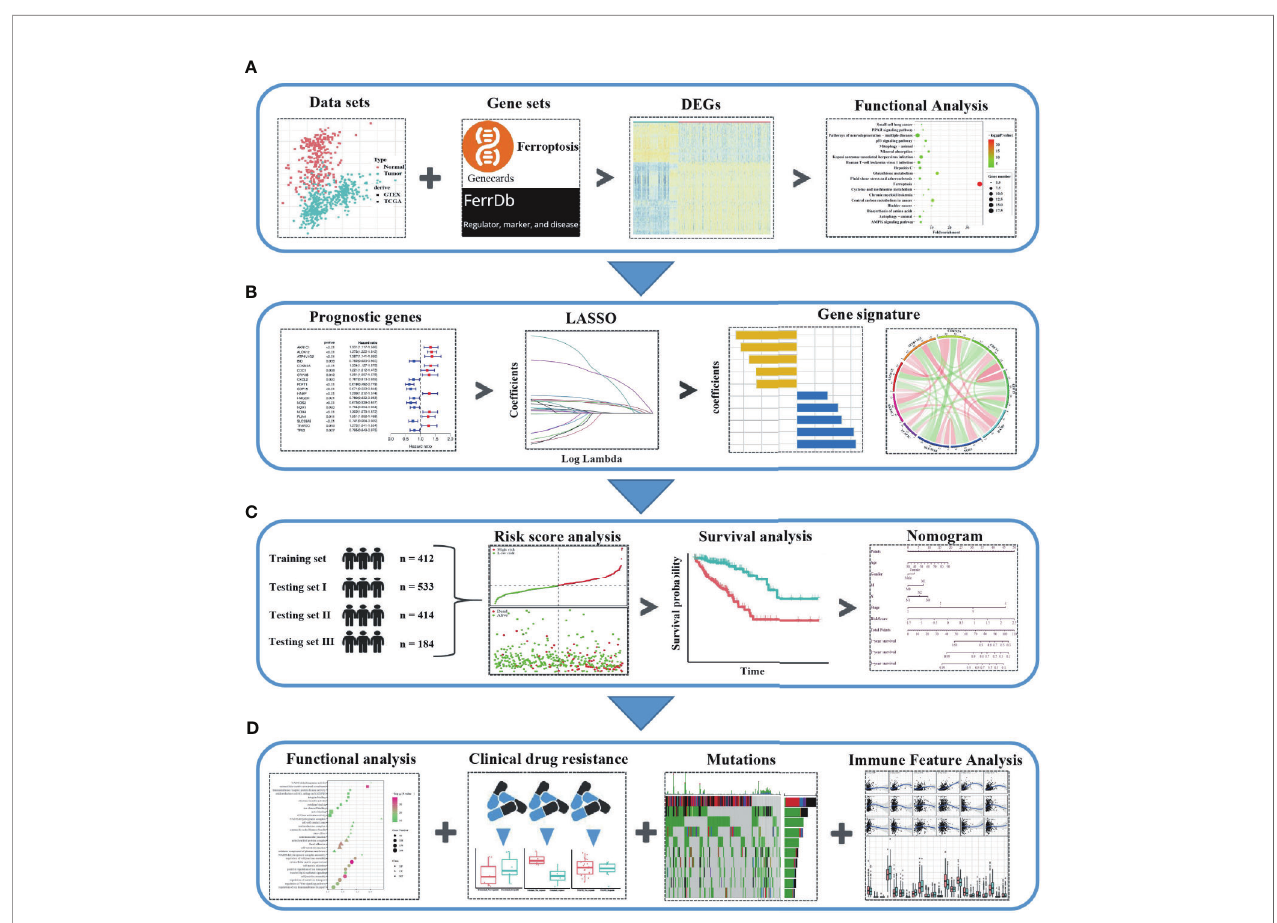
FIGURE 1 | Schematic diagram of the study design. (A) The ferroptosis-related differentially expressed genes (DEGs) were identi fi ed between the tumor and normal colon tissues in the GTEx and TCGA datasets. (B) Based on these DEGs, the survival associated ferroptosis DEGs were identi fi ed in the TCGA dataset and the LASSO COX analysis was conducted to construct the ferroptosis-related gene signature. (C) Combined methods to evaluate and verify the predictive effect of the ferroptosis-related gene signature in the multiple datasets. (D) The relationship between the ferroptosis-related gene signature and the downstream functional enrichment, drug sensitivity, somatic mutation status, and immune feature in CRC